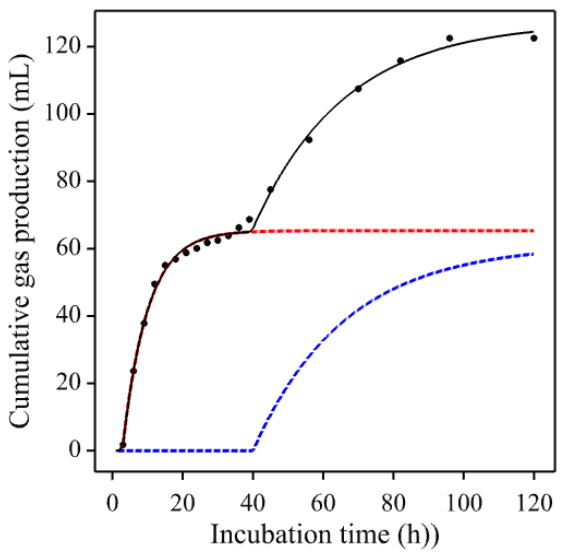
Figure 5. Two examples of non-standard GP profiles taken from Garber et al. [19] (( a ) grass hay untreated; ( b ) grass hay treated with 3.75 mL enzyme solution/kg dry matter, both incubated with an equine fecal inoculum) showing an additional linear trend (in blue) covering the asymptotic region of an underlying growth-like curve (in red). The continuous black lines show the fitted (arbitrary) mathematical equation, the purple dashed lines show the constructed equivalent simple Mitscherlich equations, and the dots represent observed 2 hourly data points.